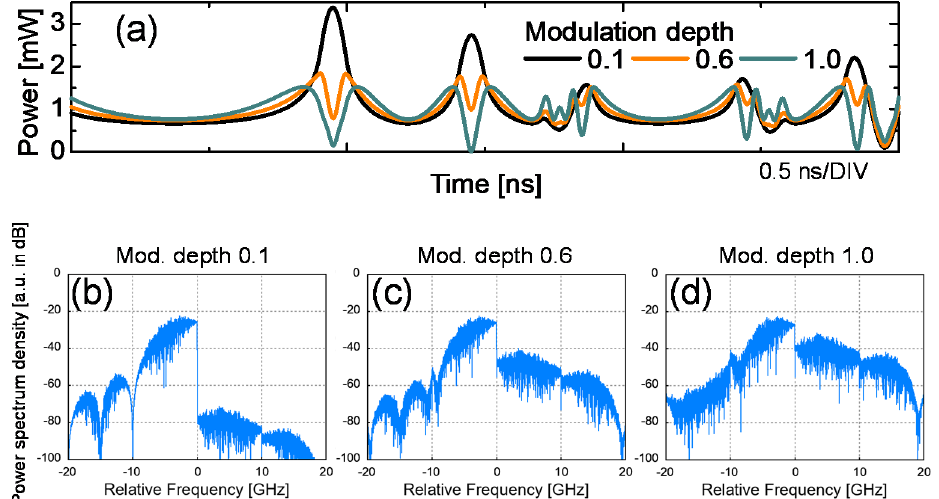
Figure 3. Waveforms and power spectra of peak-folded OSSB-SC signal, ( a ) modulator output waveforms at modulation depths of 0.1, 0.6, and 1.0, ( b – d ) power spectra of the modulator output signal at modulation depths of 0.1, 0.6, and 1.0 respectively.